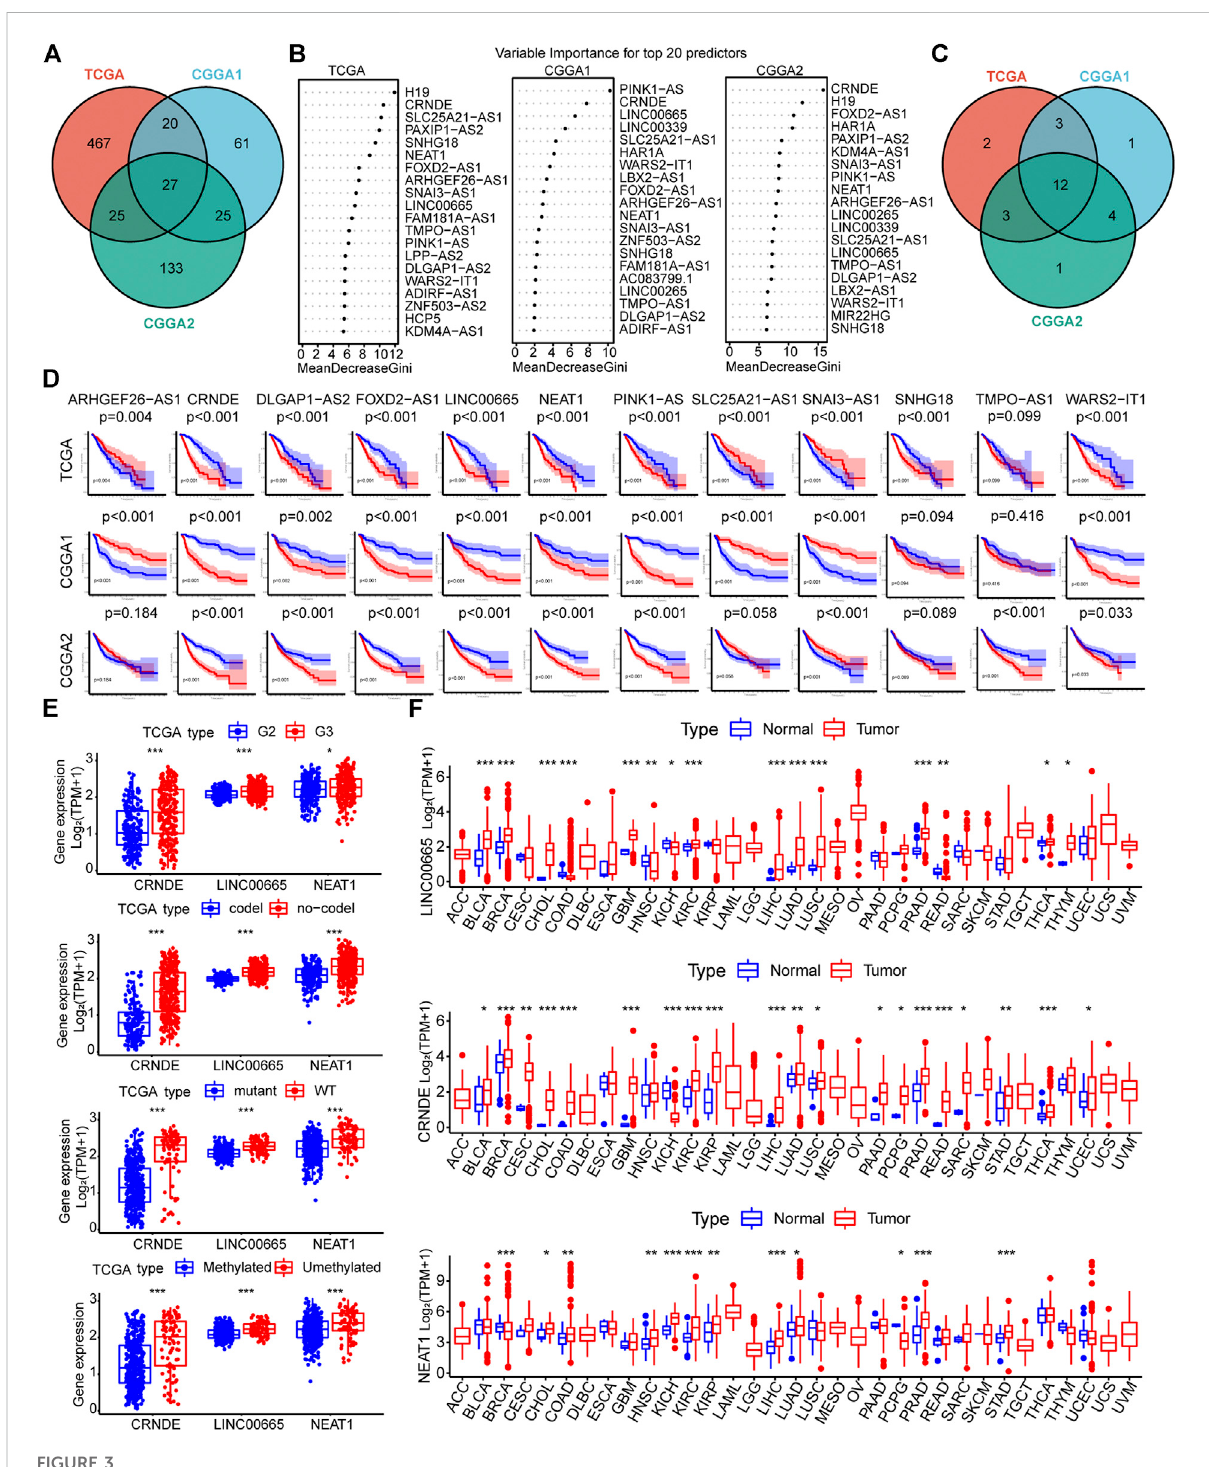
FIGURE 3 (A) Venndiagramshowingtheresults ofunivariateCoxregressionanalysisofEMT-relatedlncRNAsinthethreedatasets (B) Importanceranking of EMT-related lncRNAs based on Gini coef fi cient of the random forest algorithm (top 20) (C) Venn diagrams of the top 20 lncRNAs in the three datasets in terms of prognostic impact (D) K-M curves of 12 lncRNAs. The samples were divided into two groups based on the median value of each gene expression. Red represents the high expression group, and blue represents the low expression group (E) Expression of the three hub lncRNAs in TCGA samples with different clinicopathological parameters (WHO grade, 1p/19q, IDH, and MGMT status) (F) Pan-cancer analysis of the three hub EMT-related lncRNAs (* p < 0.05, ** p < 0.01, and *** p <